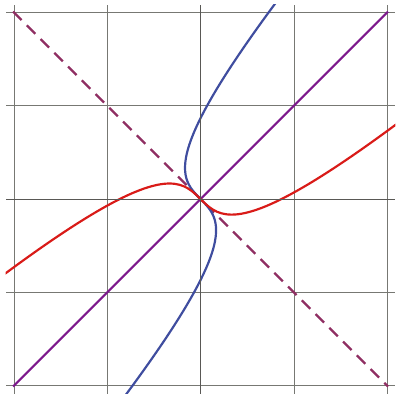
Figure 17: Spacelike ( blue ) and timelike ( red ) curves in (cid:2) 2 with (cid:2) ( ) = v ϵv , = ± ϵ 1 .